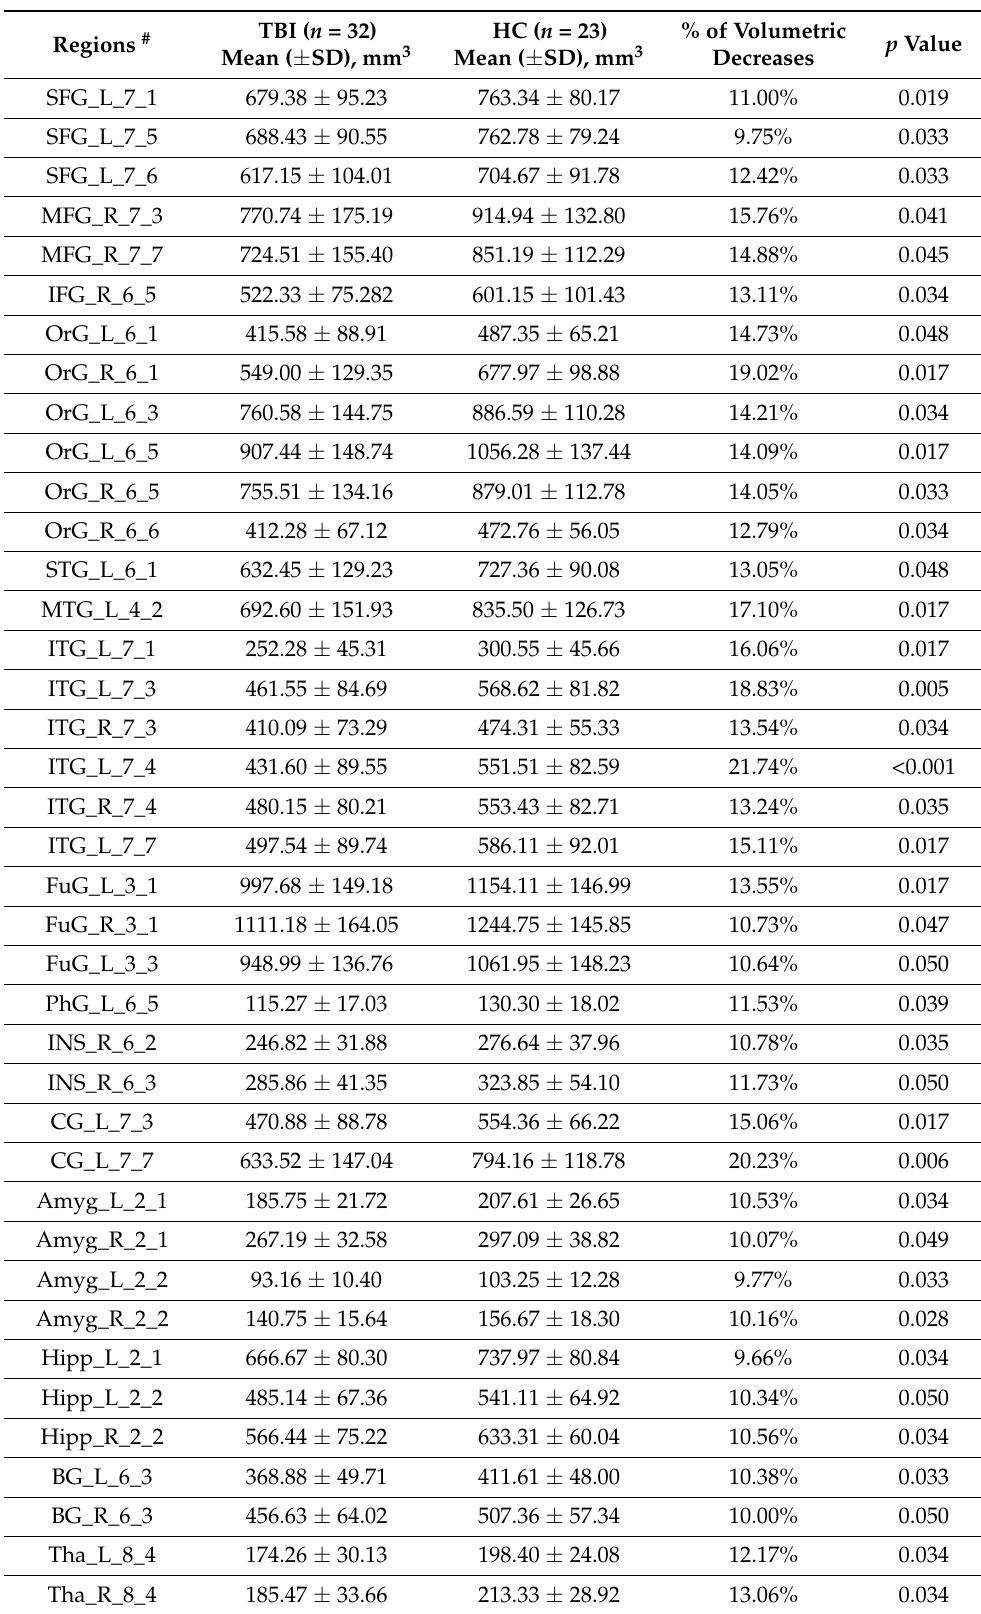
Table 2. Brain regions with statistical difference between TBI patients and healthy